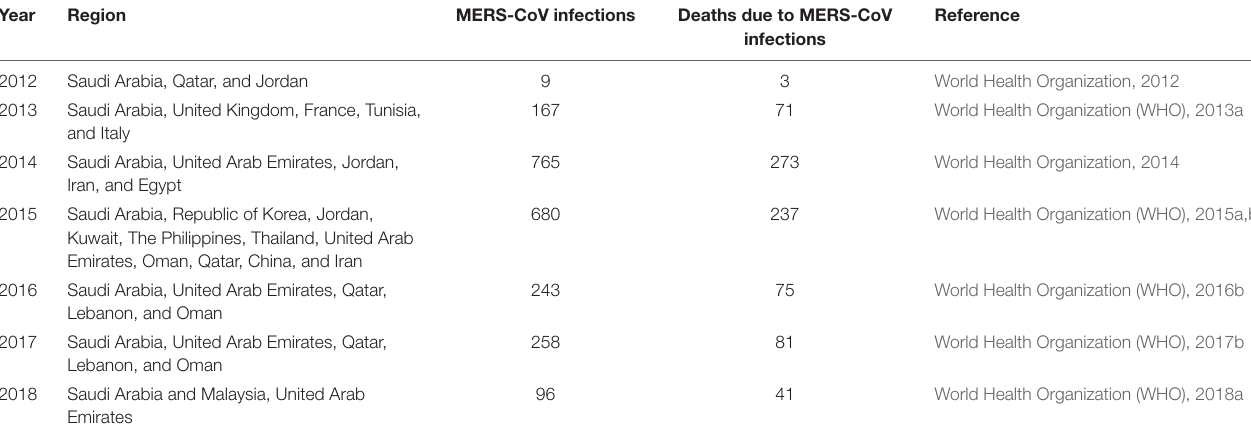
TABLE 1 | Laboratory confirmed cases of MERS-CoV infections and deaths reported in several countries from the year 2012 to